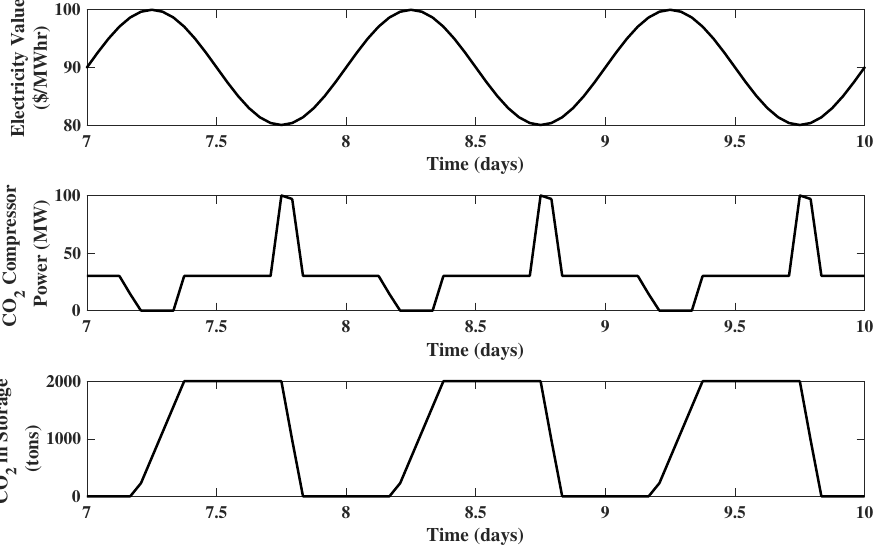
Figure 5. Closed-loop simulation of EMPC using a 24 h prediction horizon for Example